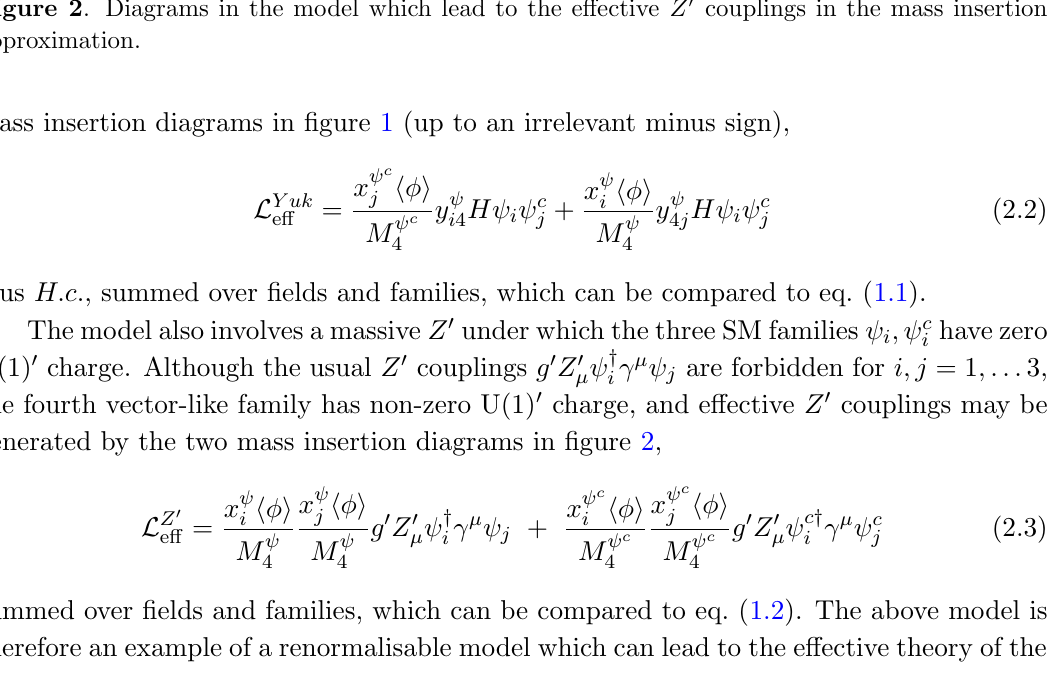
Figure 2 . Diagrams in the model which lead to the e(cid:11)ective Z